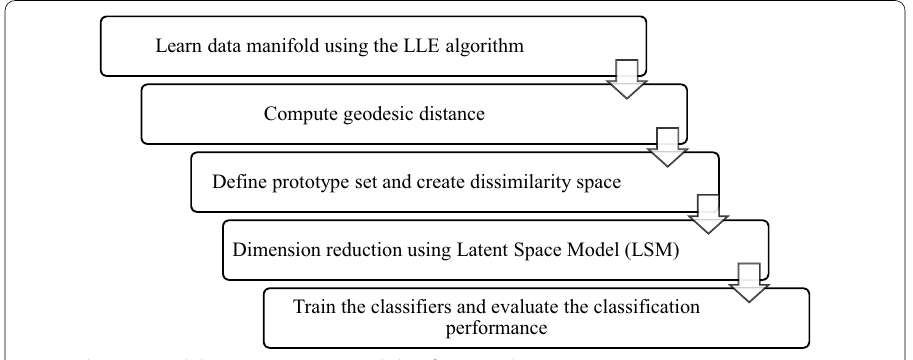
Fig. 2 The proposed data representation and classification